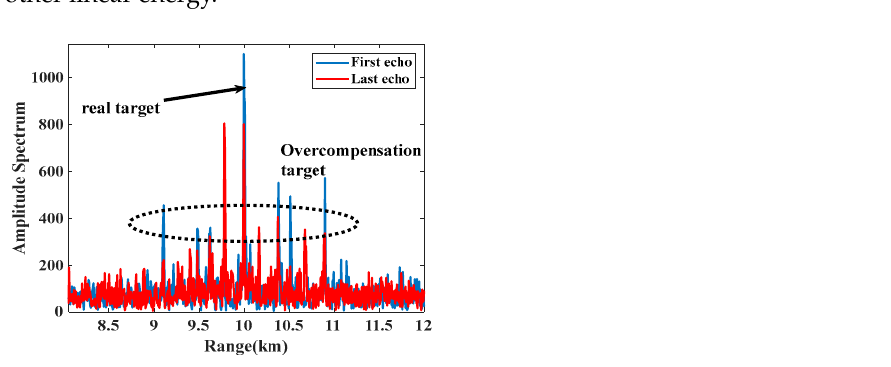
Figure 12. Pulse compression results after compensating the MTRC based on the improved Keystone algorithm.